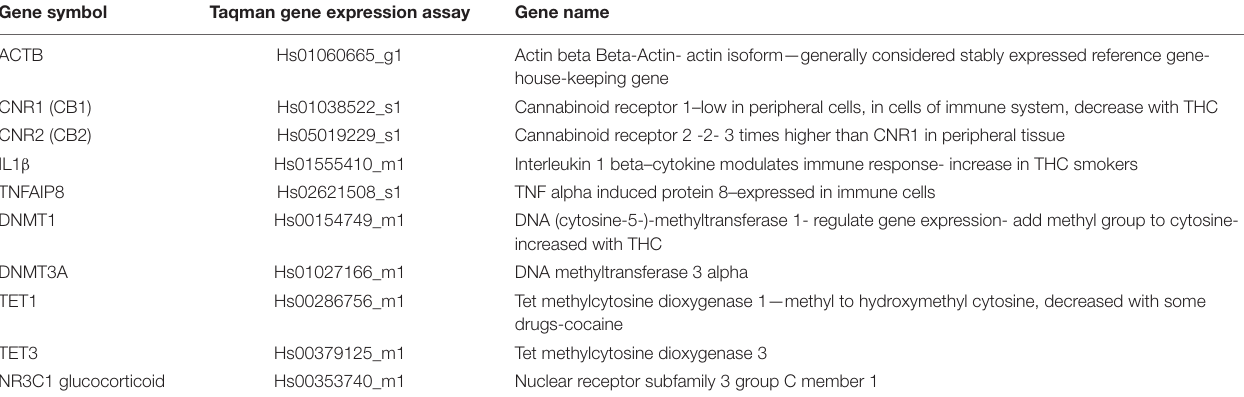
TABLE 1 | Taqman primer probes for THC study.